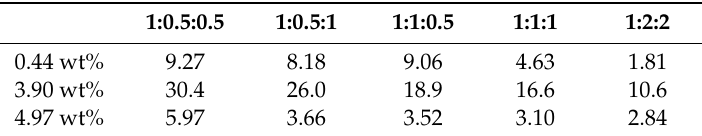
Table 5. Comparison of the maximum molar quantity of CO per unit weight of photocatalyst with illumination time among di ff erent molar ratios of CO 2 / H 2 / H 2 O and Pd loading weight with UV light illumination (unit: µ mol / g).